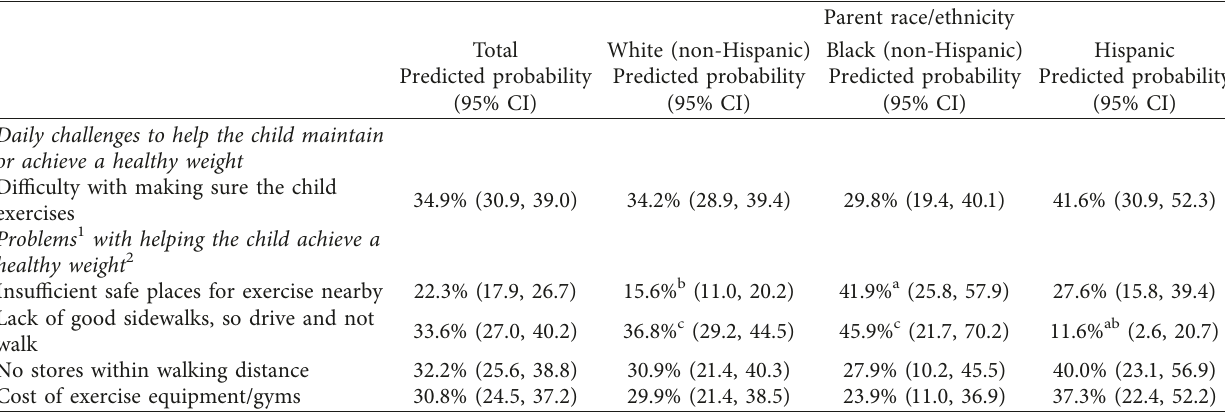
Table 4: Differences in the probability of reported daily challenges in helping their children exercise to maintain or achieve a healthy weight, by parent race/ethnicity ( n �